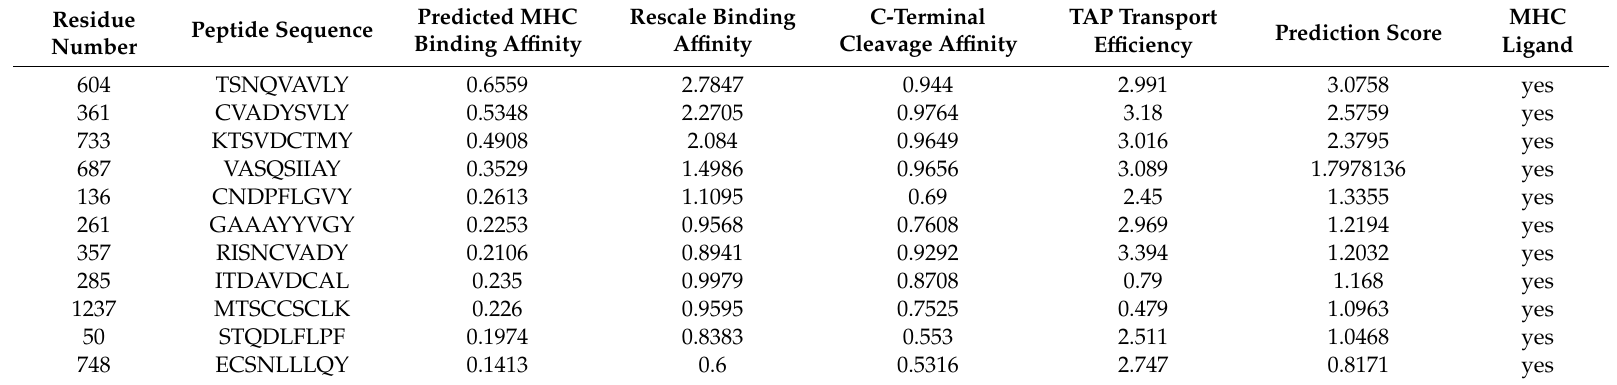
Table 5. Predicted CTL from SARS-CoV-2 S protein *. TAP, transporter associated with antigen processing.